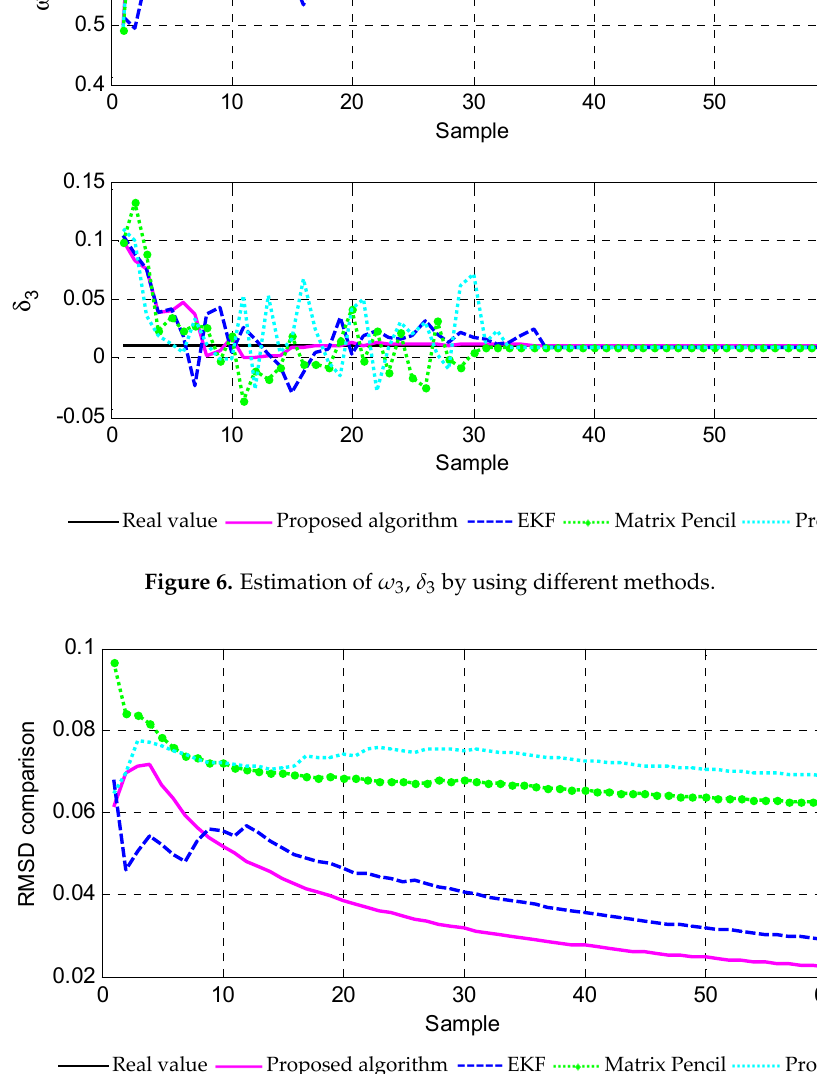
Figure 7. Comparisons of average estimation errors.